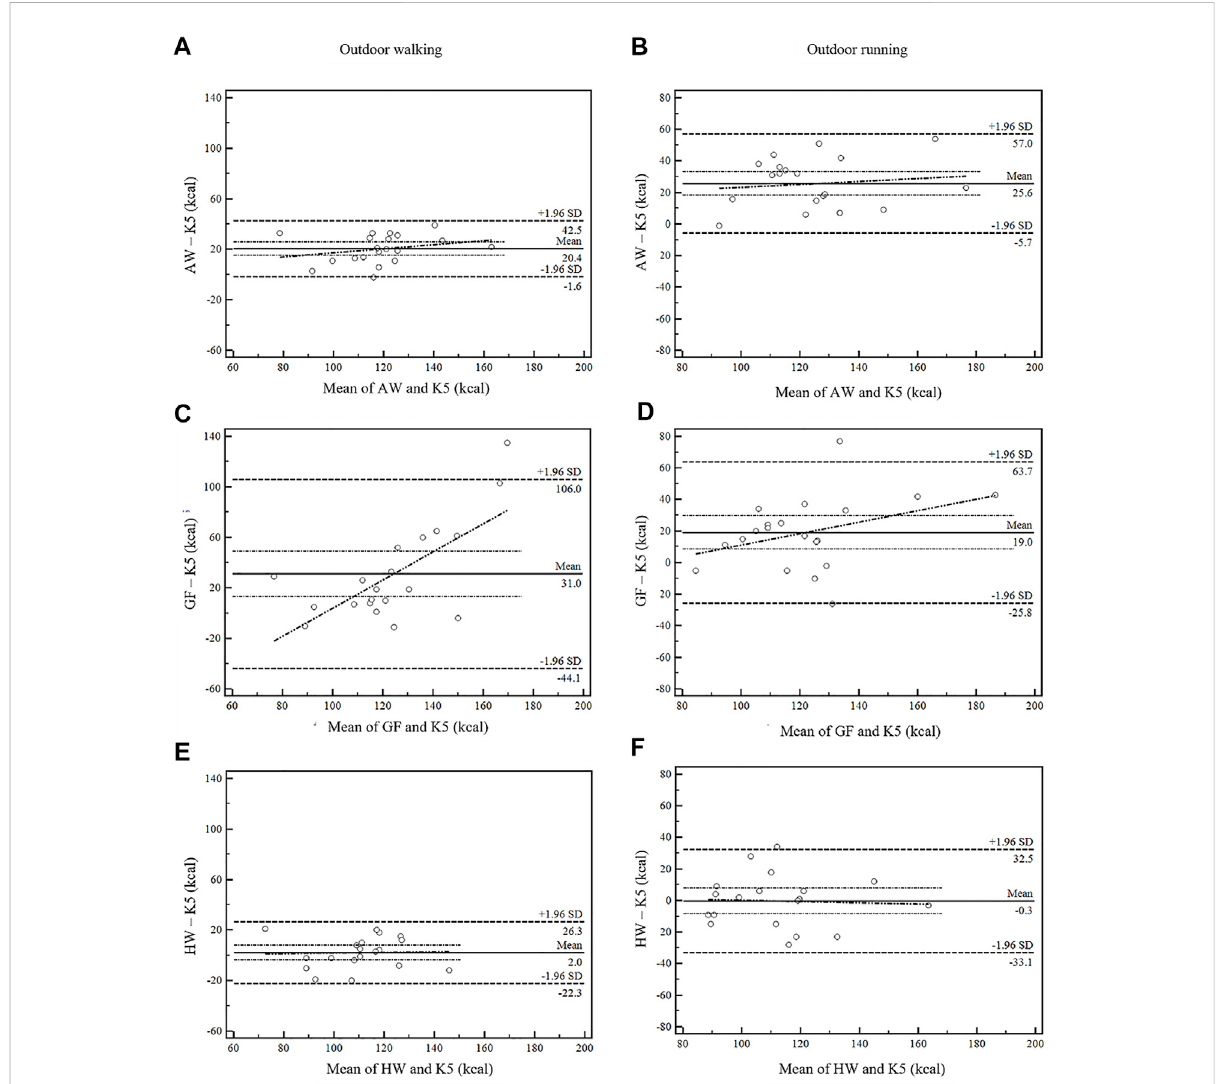
FIGURE 2 Bland-Altman plots comparing the EE estimations by smartwatches (AW (A,B) , GF (C,D) , HW (E,F) ) and K5. The differences of the EE values on the y -axis relative to the mean of the two methods (smartwatch and K5) on the x -axis. Mean differences (bias) between estimated EE and EE of criterion,upperandlowerlimitsofagreement(ULoA,LLoA)arelabeledintheplots.Limitsofagreement(LoA)werecalculatedasmeans±1.96SD.K5, the criterion of EE assessment; AW, Apple Watch Series 6; GF, Garmin FENIX 6; HW, Huawei Watch GT 2e; SD, standard